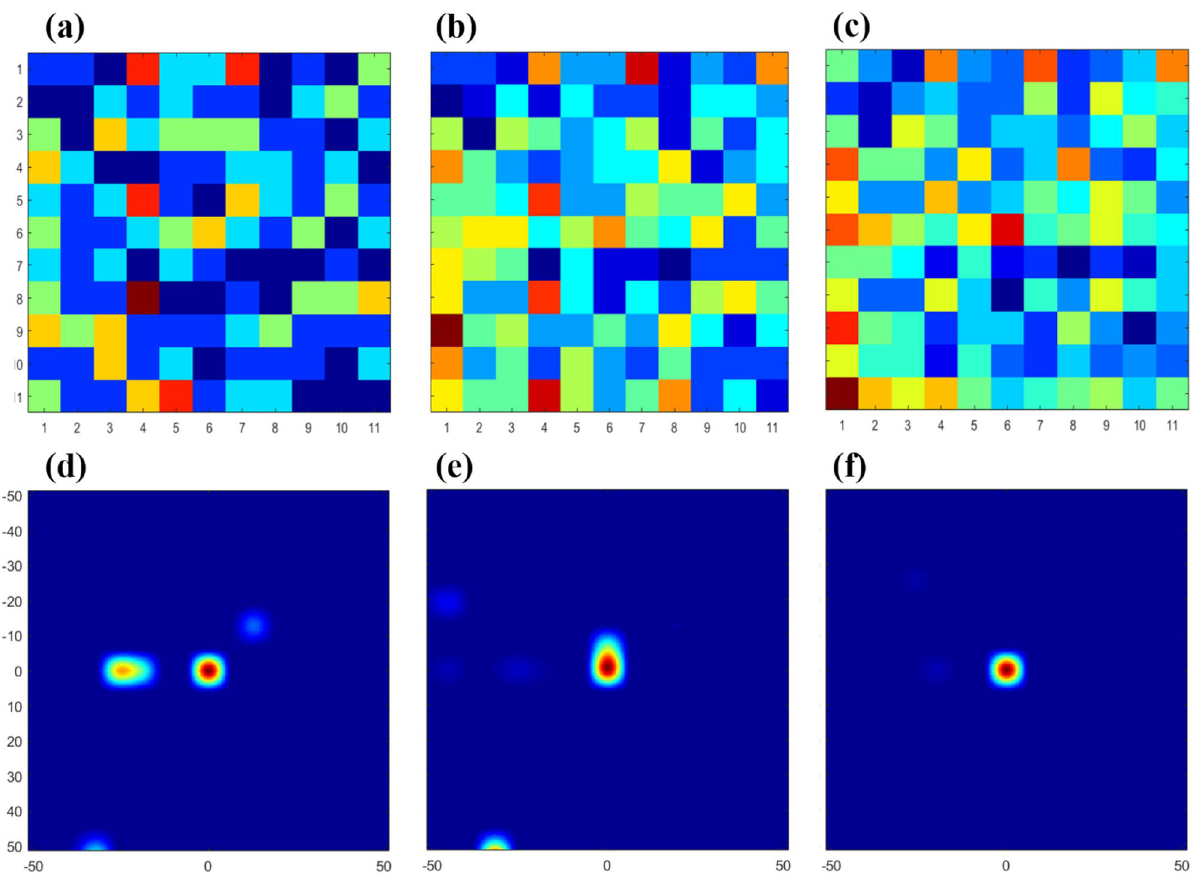
Figure 8. Comparison of reconstructed images of gamma-ray events when exposed to a 137 Cs source producing 6.4 μR/h at 100 cm distance. The detector map composed of the gamma-ray events for ( a ) 20 s (300 events), ( b ) 40 s (600 events), and ( c ) 69 s (1,000 events). The three detector maps correspond to the images reconstructed by using MLEM ( d–f ), respectively. Number of gamma-ray events above 200